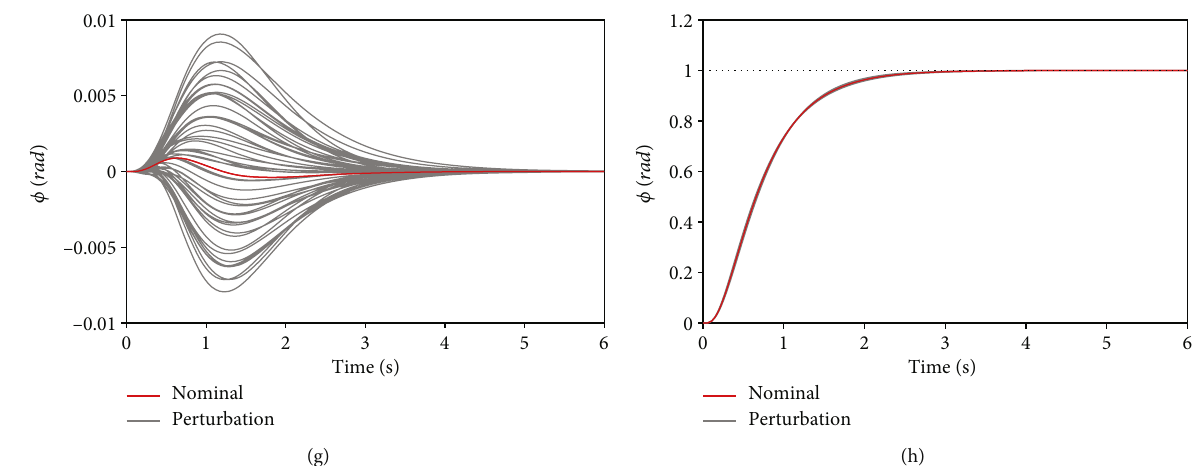
Figure 13: Step response of the closed loop with EA control. (a) a response. (e) a